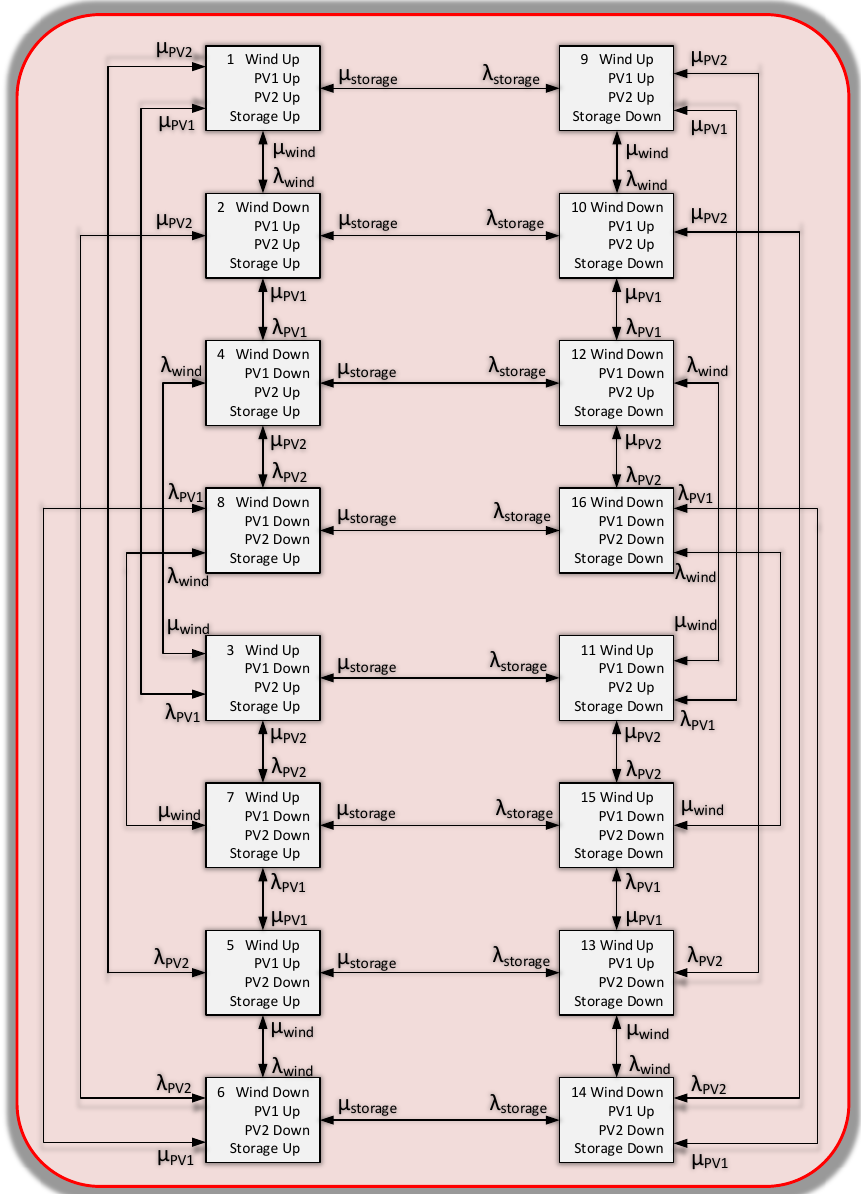
Figure 11. State-space diagram showing each unique state of the distribution network system shown in Figure